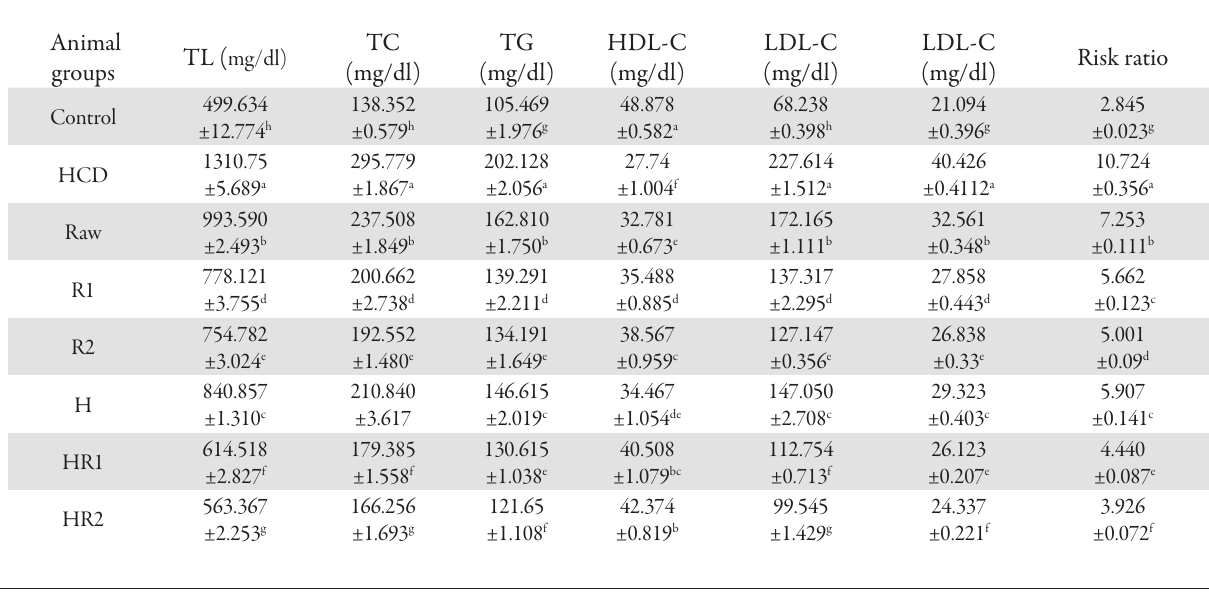
Tab. 2. Effects of dietary supplementation by raw and treated soy flour to HC rats on lipid